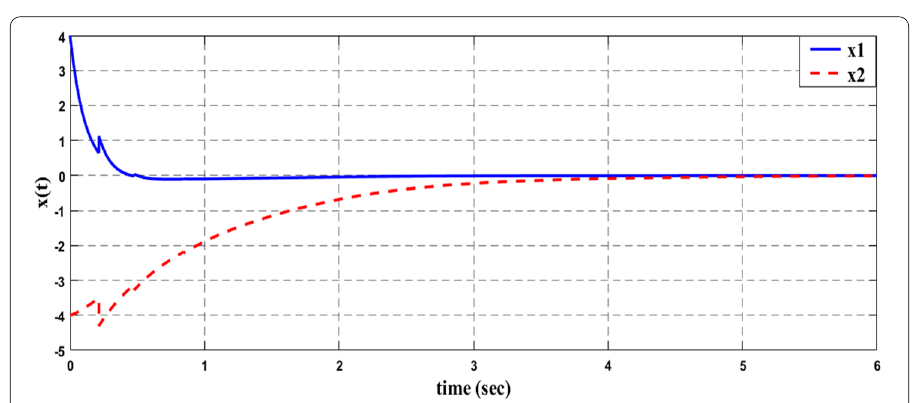
Figure 3 The simulation of Example 4.3 for